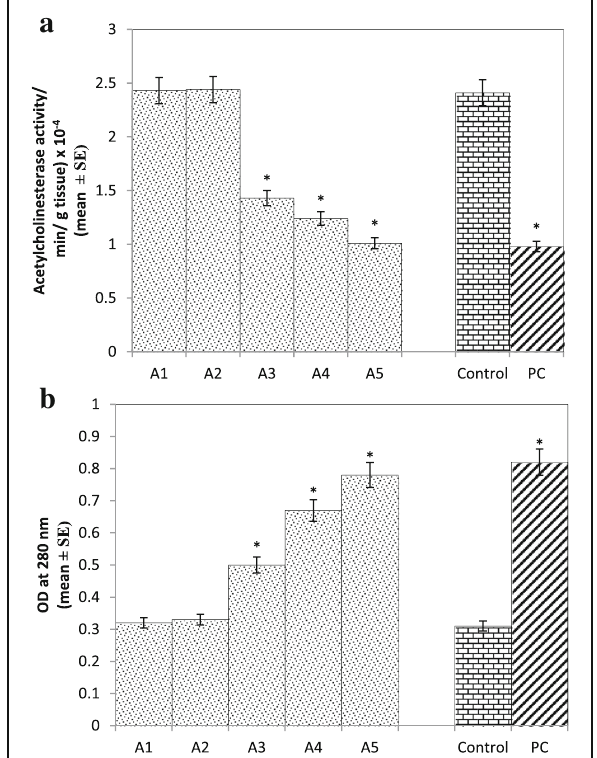
Fig. 3 Acetycholineesterase ( a ) and monoamine oxidase ( b ) activities measured in flies exposed to various doses of arecoline (A1 = 5 μ M arecoline, A2 = 10 μ M arecoline, A3 = 20 μ M arecoline, A4 = 40 μ M arecoline, A5 = 80 μ M arecoline, PC = 10 μ l/ml methyl methanesulphonate), * significant at p < 0.05 compared to control